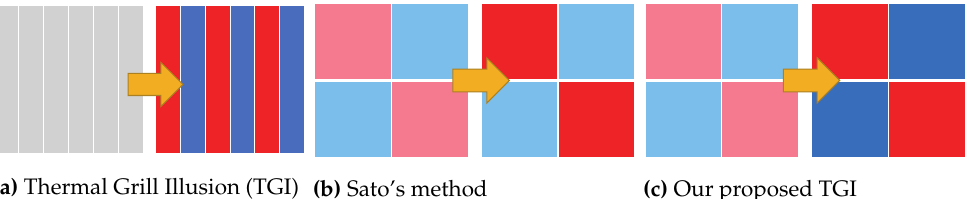
Figure 1. Thermal change patterns of each method. ( a ) Thermal stimulation on TGI. The stimulation was arrayed in a row. ( b ) Thermal stimulation on Sato’s method. Peltier elements are grid-arrayed, and a part of the thermal pattern is changed. ( c ) Thermal stimulation on the proposed method. Peltier elements are grid-arrayed, and both parts of the thermal pattern are